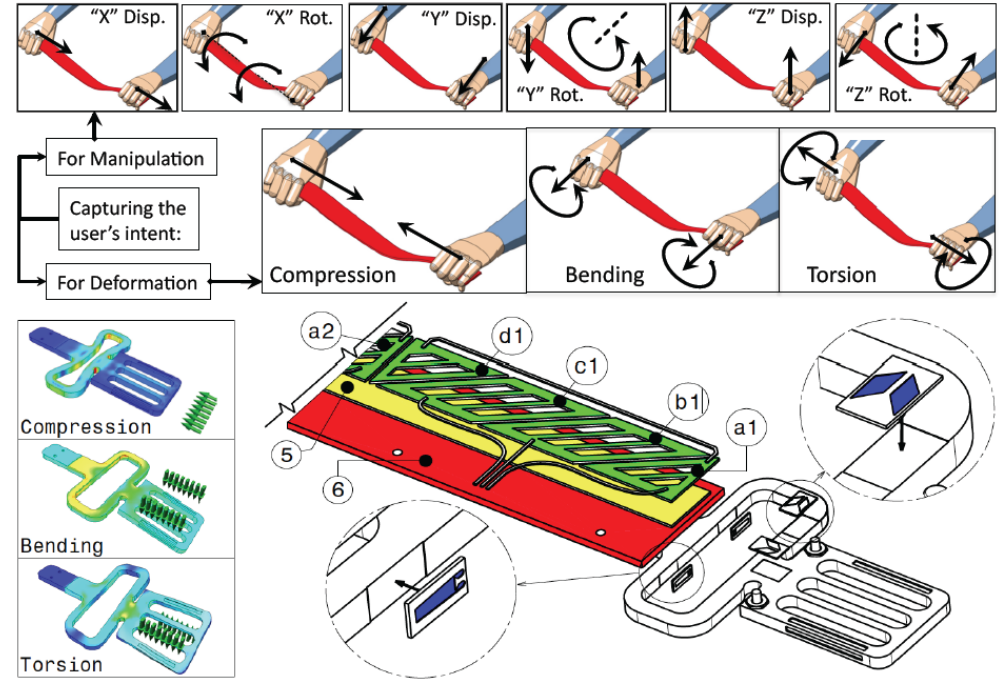
Figure 2. Force sensitive handles (FSH)